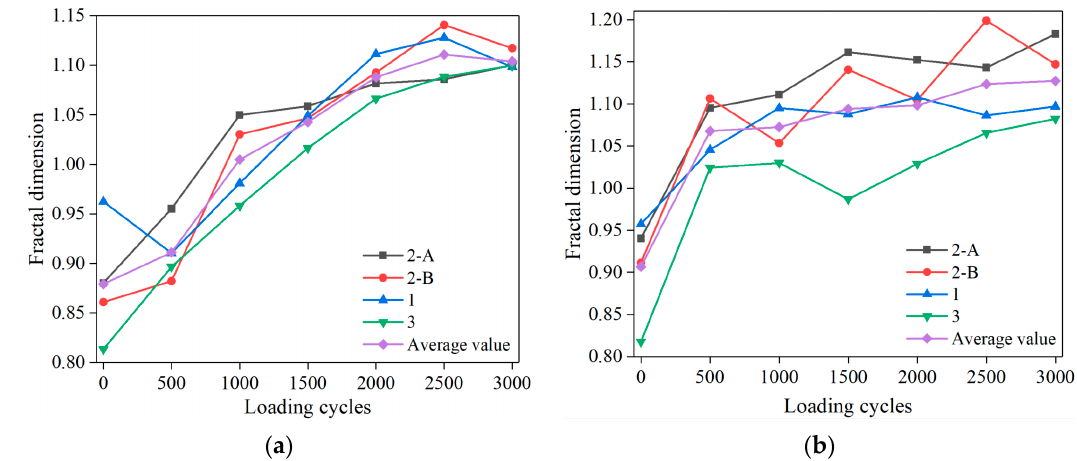
Figure 10. Relationship between fractal dimension and loading cycles: ( a ) AC-13; ( b ) AC-16.